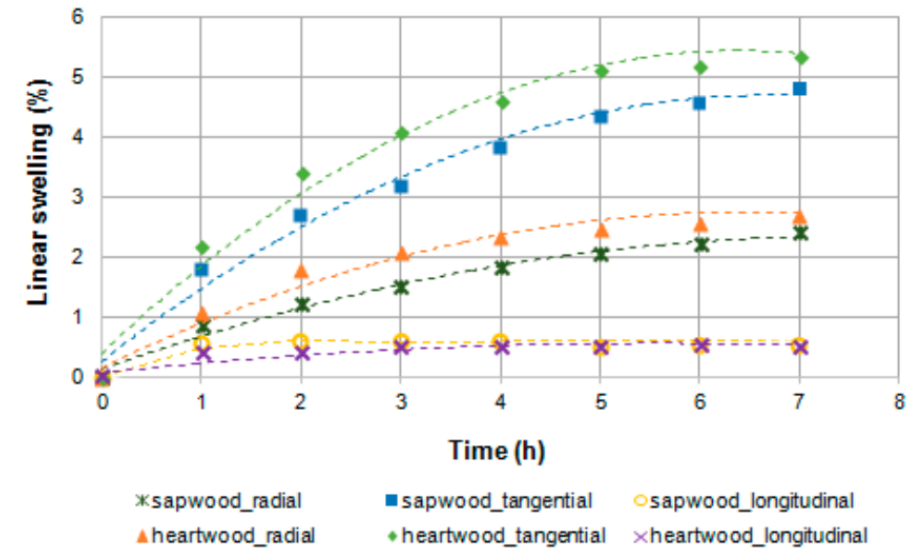
Figure 8. Swelling in the radial, tangential, and longitudinal directions of the sapwood and heart- wood of oriental